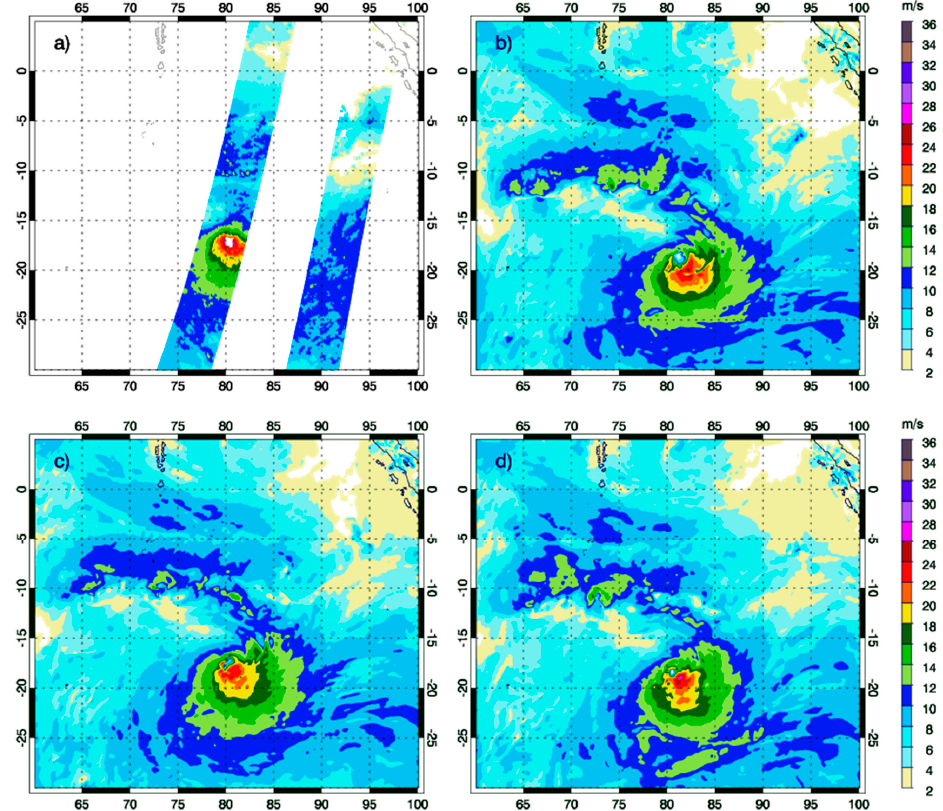
Figure 6. Surface wind speed from ( a ) ASCAT around 0239 UTC and ( b ) CTRL, ( c ) DA_cyg_fd, and ( d ) DA_cyg_lf at 0300 UTC on 8 January